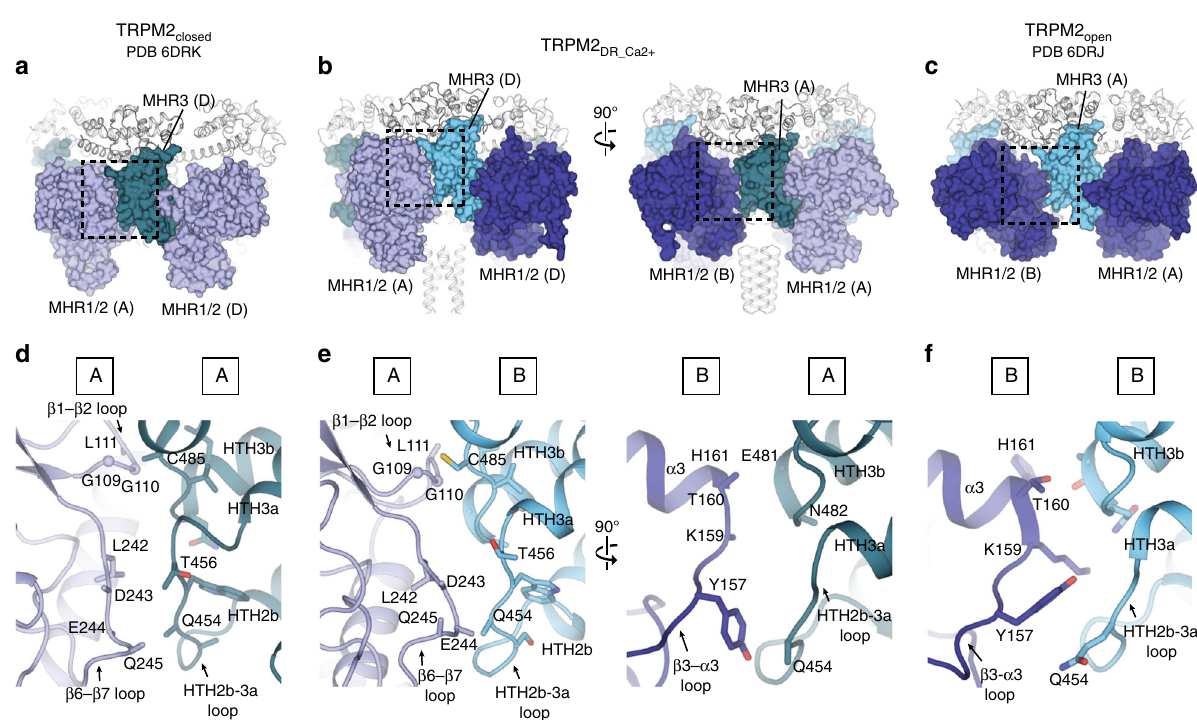
Fig. 7 Subunit – subunit interfaces in the middle layer of CD. Comparison of the interaction networks between the neighboring subunits mediated by MHR1/ 2 and MHR3 domains in the TRPM2 closed ( a , PDB 6DRK), TRPM2 DR_Ca2 + ( b ), and TRPM2 open ( c , PDB 6DRJ) structures. Close-up views of regions highlighted by dashed squares in a – c correspondingly. In the TRPM2 DR_Ca2 + structure, the interface between MHR1/2 in protomer A and MHR3 in protomer D (equivalent to B) ( e , left panel) resembles the interfacial network in the TRPM2 closed structure ( d ); the interface between MHR1/2 in protomer B and MHR3 in protomer A ( e , right panel) is similar to that in the TRPM2 open structure ( f